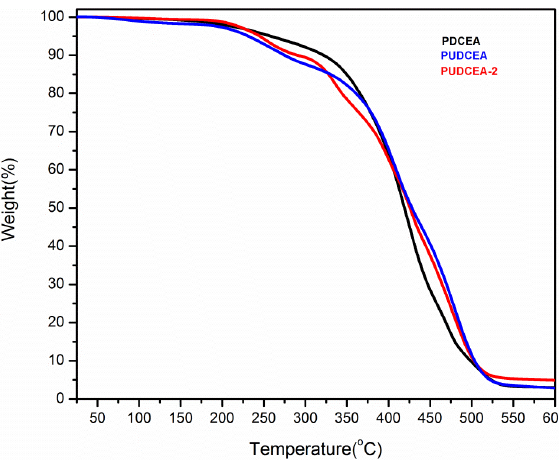
Figure 9. TGA thermogram of PDCEA, PUDCEA and PUDCEA-3